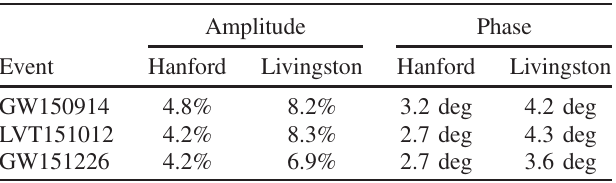
TABLE III. The standard deviations used for the (zero-mean) Gaussian priors on calibration uncertainty for each of the three events. The calibration of each of the two detectors has been independently assessed [47]. These priors set the expected variation for the frequency-dependent spline model used to incorporate the effects of calibration uncertainty [191].